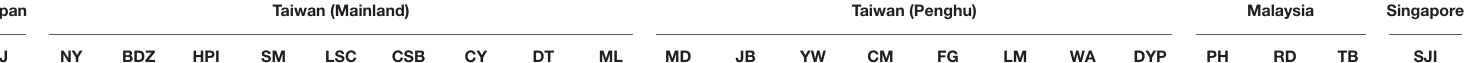
TABLE 2 | Pairwise comparisons of F ST values for Eriphia ferox populations.